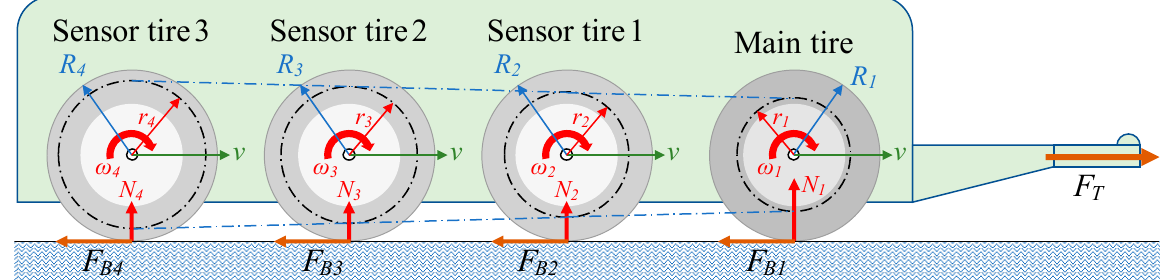
Figure 15. Trailer-type measurement system.